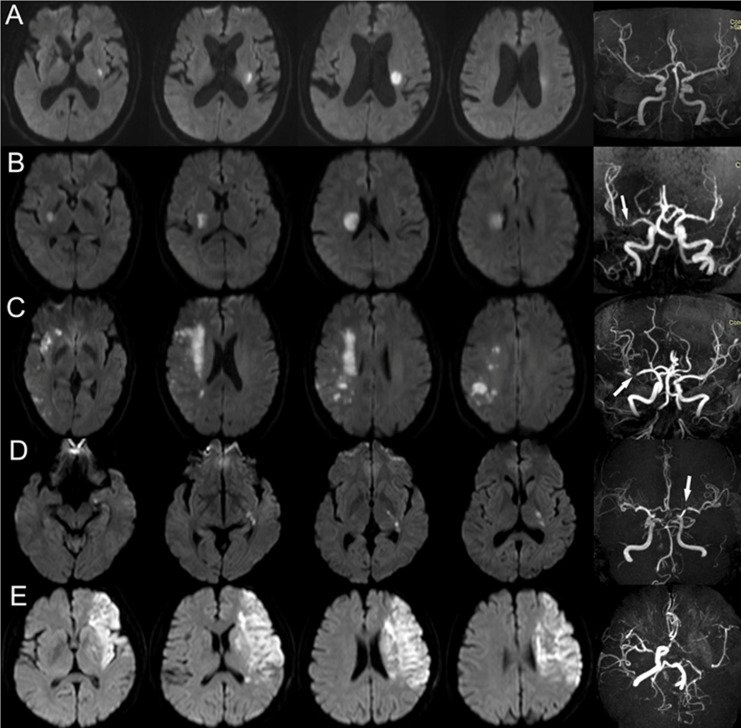
Topographical Distribution of Acute Ischemic Stroke in Internal Carotid Artery (ICA) or Middle Cerebral Artery (MCA) Territory.A. Single acute infarct in left lenticulostriate artery of MCA territory, without obvious stenosis of left MCA. Small artery occlusion was the most possible etiologic subtype. B. A single acute infarct in right lenticulostriate artery territory, with obvious stenosis in M1 segment of RMCA. Large artery atherosclerosis (LAA) and parent artery occluding penetrating artery was the etiologic subtype and most possible stroke mechanism. C. Multiple acute infarcts (including internal watershed infarcts, cortical watershed infarcts, and small cortical infarct) in right MCA territory, with obvious stenosis in M1 segment of right MCA. The etiologic subtype was considered LAA. D. Single acute infarct in left anterior choroidal artery of ICA territory, with obvious stenosis in C7 segment of left ICA. LAA and parent artery occluding penetrating artery was considered as the etiologic subtype and most possible stroke mechanism. E. Multiple acute infarcts (including territorial infarct and penetrating artery infarct) in left ICA territory with occlusion of left ICA. The etiologic subtype was considered LAA.